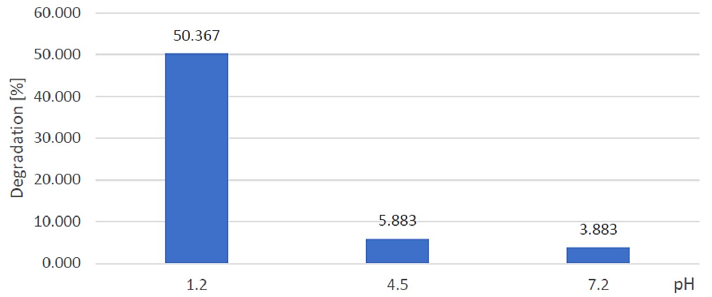
Figure 7. In vitro simulation of 5-DCB digestion: Stomach (gastric phase, at pH 1.2 and pH 4.5) and duodenum (small intestinal phase, at pH 7.2). 5-DCB: Diester chlorogenoborate.